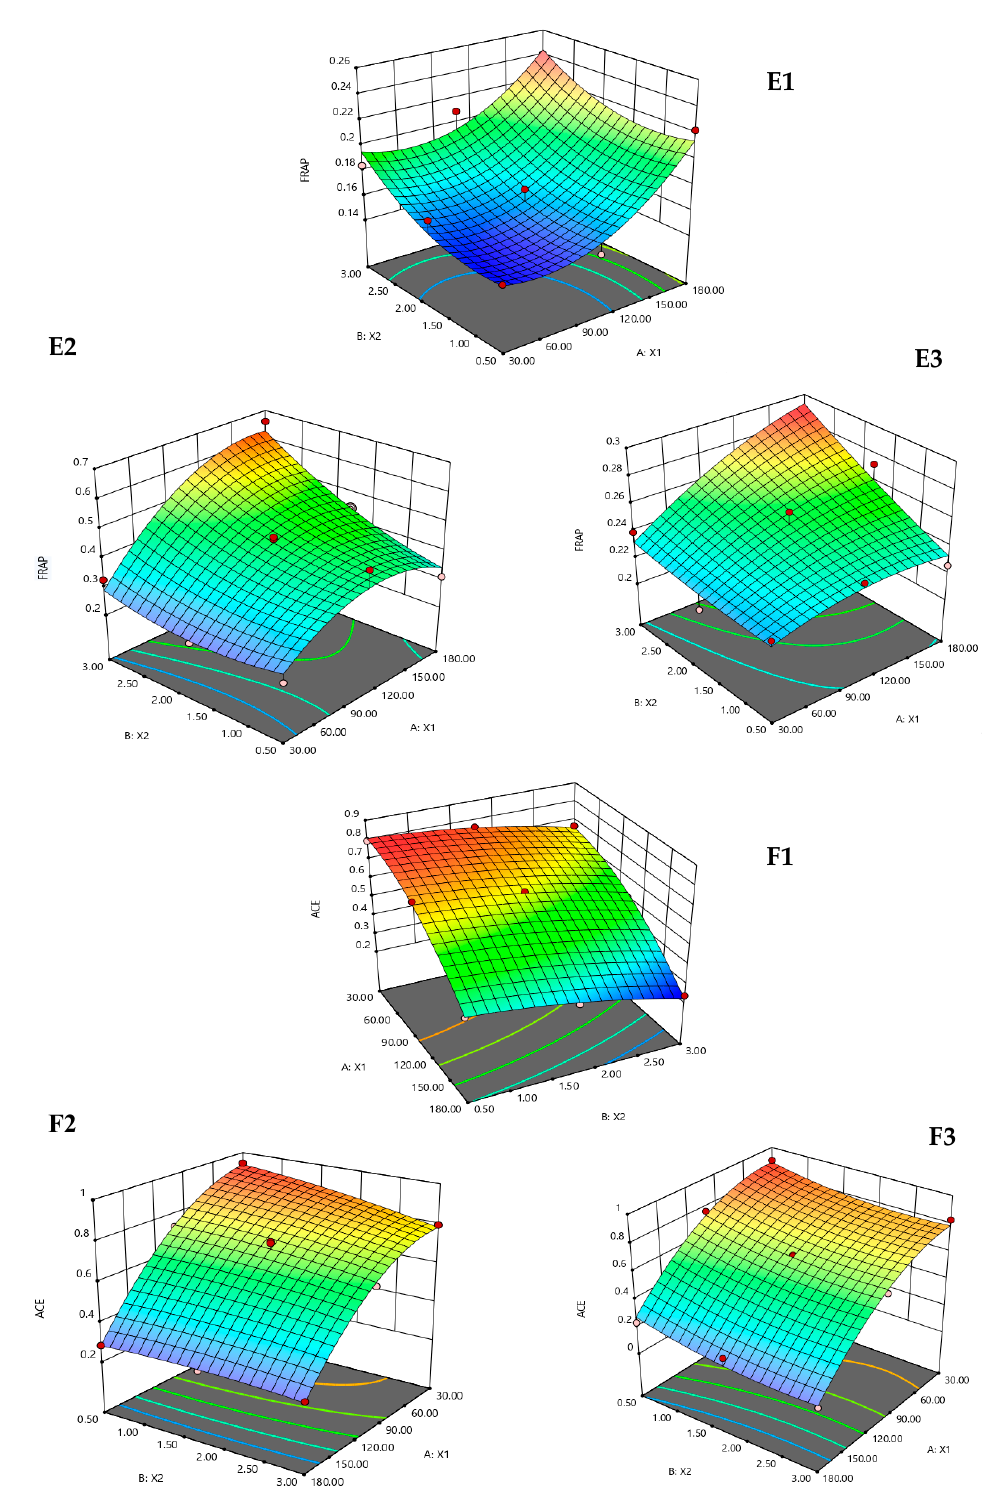
Figure 1. Response surface plots for the effect of hydrolysis time (X 1 ; min) and enzyme concentration (X 2 ; %) on the DH, yield, DPPH radical scavenging activity, ABTS radical scavenging activity, FRAP assay and ACE inhibitory activity using Alcalase (A1 – F1 ), Neutrase ( A2 – F2 ) and Flavourzyme ( A3 – F3 ) hydrolysis .